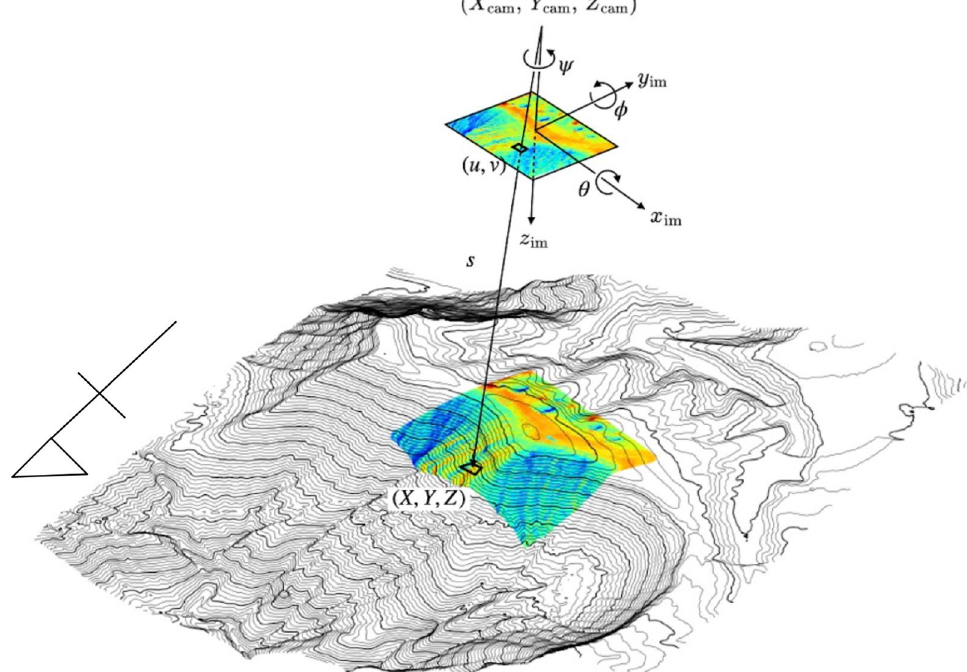
Fig. 4 Schematic illustration of the georeferencing process The TIR image is overlaid onto the DEM surface by converting the pixel coordinate ( u , v ) into the world coordinate ( X , Y , Z ). External parameters are also